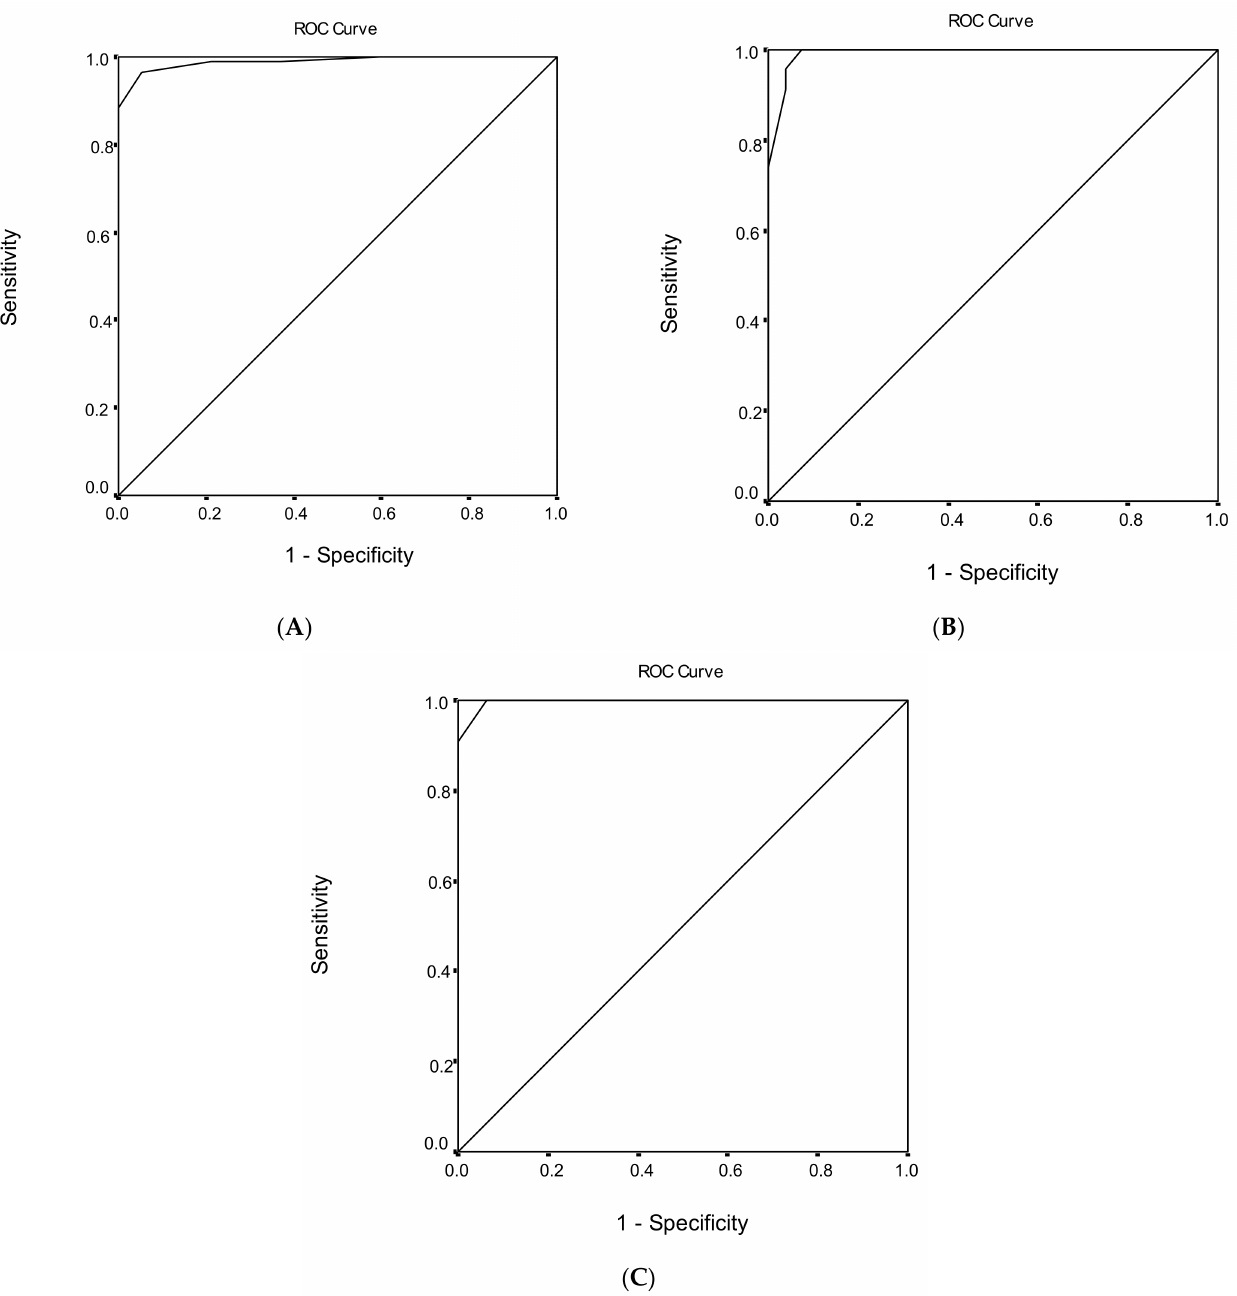
Figure 3. Receiver operating characteristic (ROC) curve analysis of the Montreal Cognitive Assessment (MoCA) to discrimi- nate between mild cognitive impairment (MCI) and dementia under ( A ) low, ( B ) medium, and ( C ) high educational